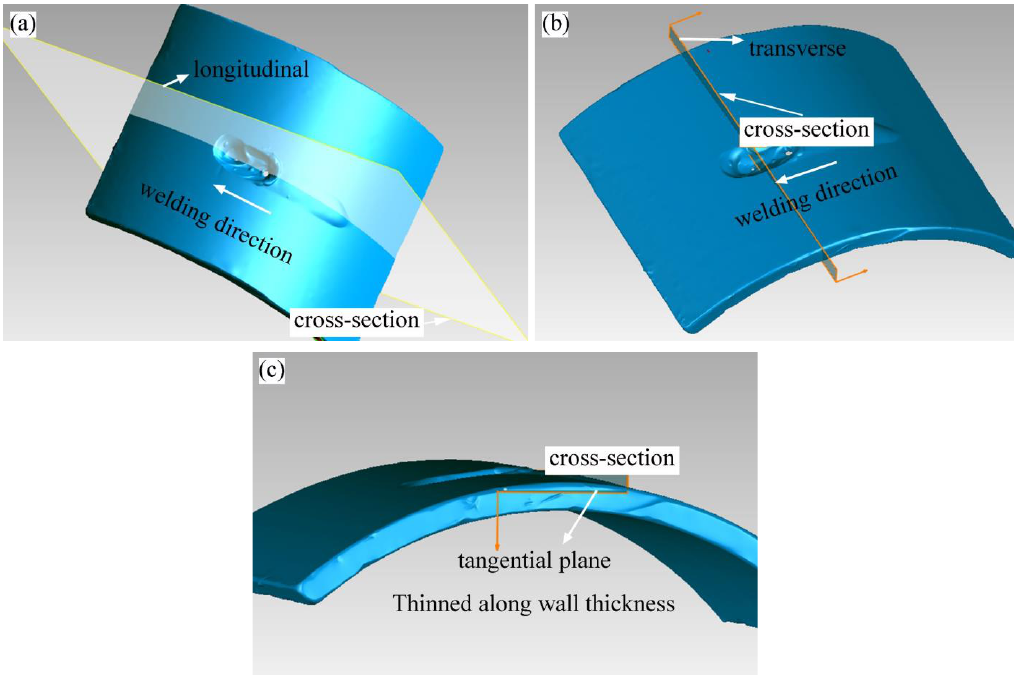
Figure 13. Method of cutting samples: ( a ) cut along the longitudinal path; ( b ) cut along the transverse path; ( c ) cut along the tangential path.